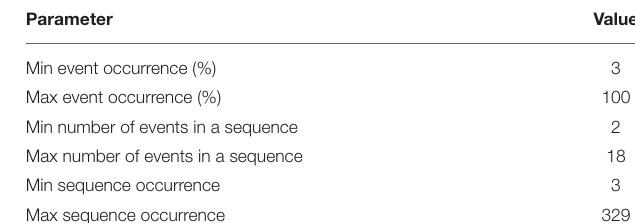
TABLE 4 | Preprocessing parameters for Markov chain sequence clustering for England’s team.